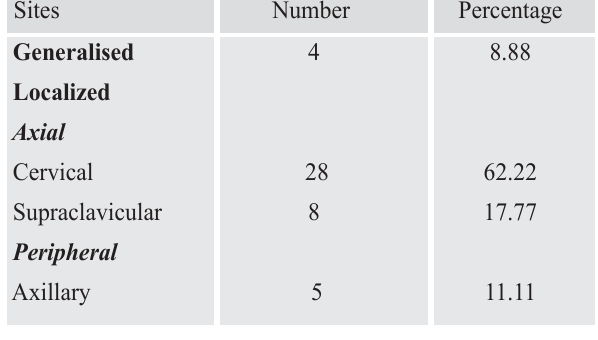
Table III: Histopathological types of Hodgkin